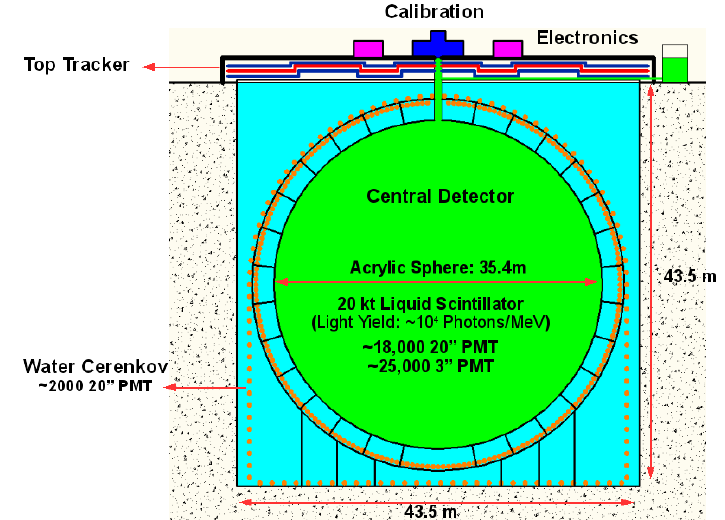
Figure 1. Schematic view of the JUNO